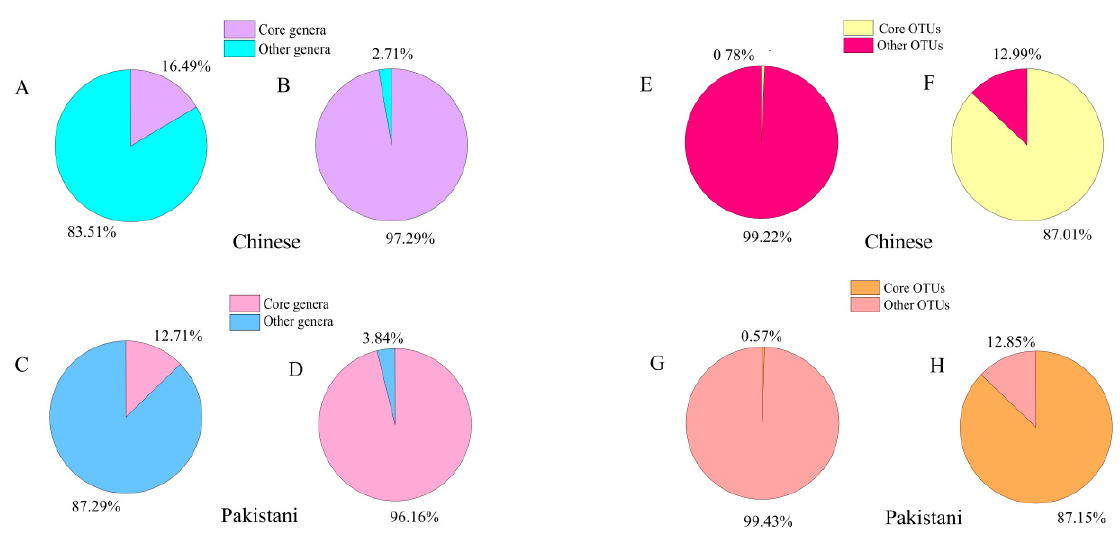
Figure 5. The proportion of specie-numbers and the relative abundance of core microbiome in Pakistani and Chinese at genus level ( A – D ) and OTU level ( E – H ).